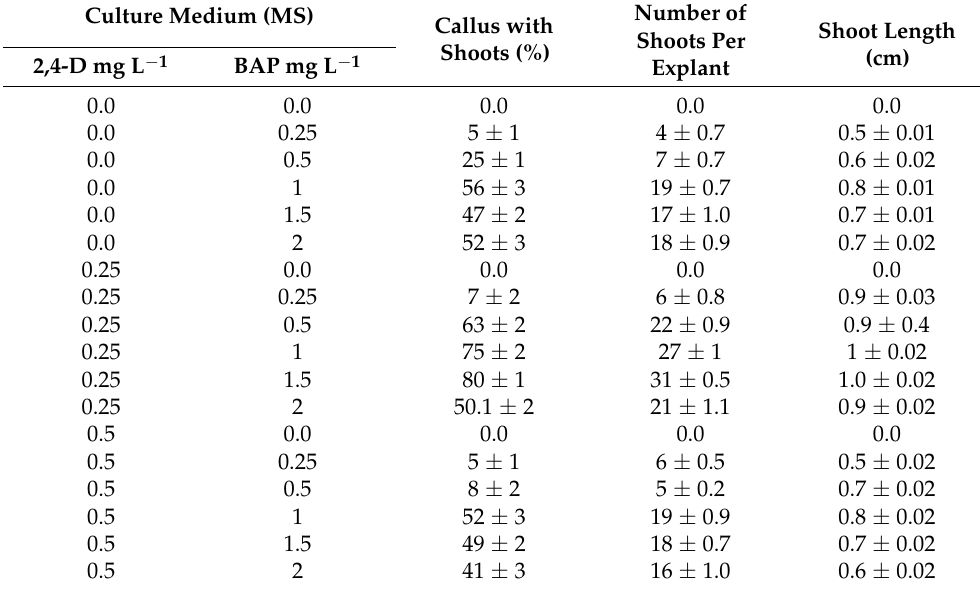
Table 3. Effect of different concentrations of 2,4-D and BAP on shoot regeneration from Carum copticum callus on MS